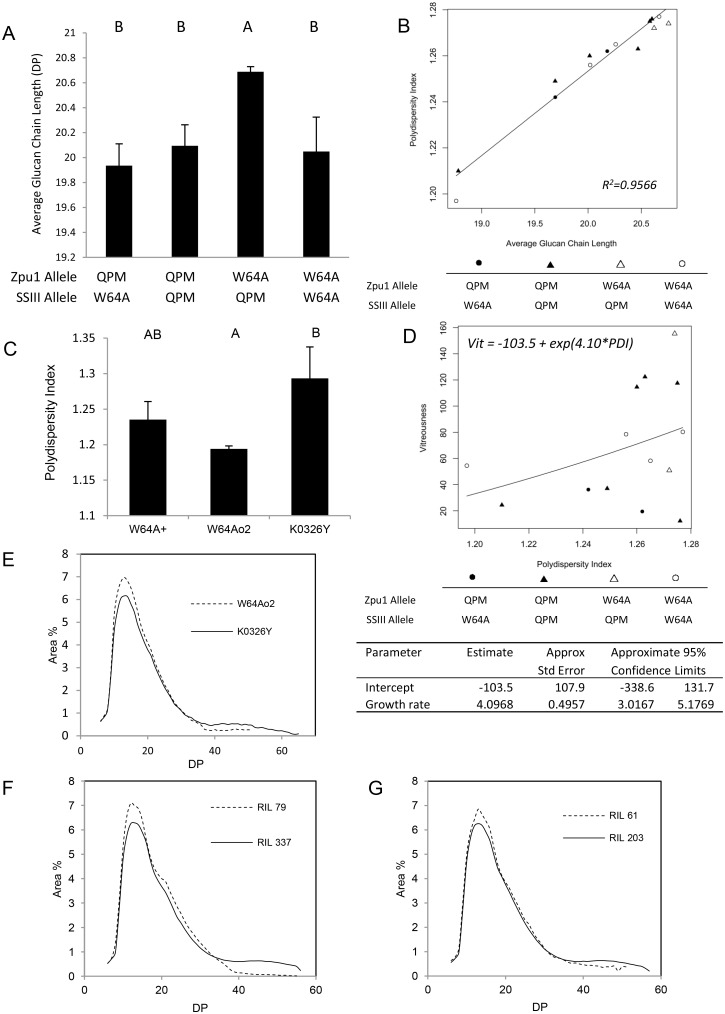
Average glucan chain length and polydispersity index (PDI).(A) Comparison of the average glucan chain length among RILs. Each column contains multiple lines homozygous for the parental alleles (W64Ao2 or QPM) of Zpu1 or SSIII. Each column represents mean glucan chain length of all RILs of the corresponding genotype with three independent ears of each individual RIL. (B) Positive correlation between average glucan chain length and PDI. The correlations are significant, tested by ANOVA of the slope at p<0.05. Each data point represents mean glucan chain length of three independent ears of each individual RIL. (C) Comparison of PDI between parental lines (W64A+, W64Ao2 and K0326Y). Each column represents the mean PDI value of three independent ears of corresponding lines. The letters above each column of (A) and (C) represent statistically significant differences among the lines for p<0.05 by each pair t test. Columns sharing the same letter are not significantly different from one another. The error bars represent corresponding standard error. (D) Nonlinear regression analysis between PDI and kernel vitreousness among RILs, test statistics are listed below. The relationship was significantly positive, because 0 was excluded from the 95% confidence interval of Growth Rate, indicating that the Growth Rate was greater than 0 at p-value = 0.05 level. Each data point represents mean PDI of three independent ears of each individual RIL. (E-G) Glucan chain length distribution between opaque lines (dash curves) and vitreous lines (solid curves).